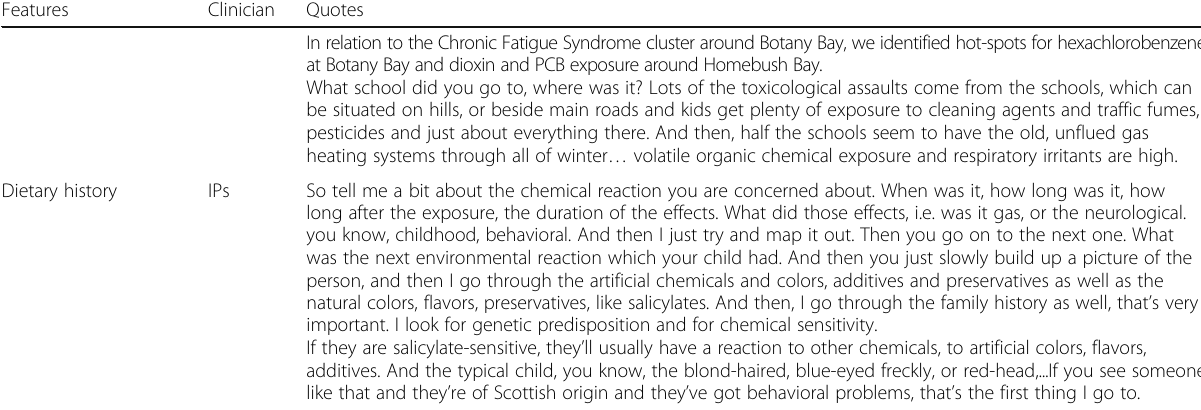
Table 3 The environmental exposure history is the most important clinical tool